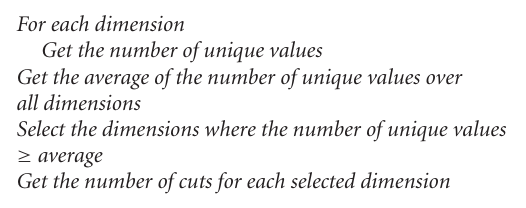
Algorithm 1: Heuristic to select the dimensions to cut